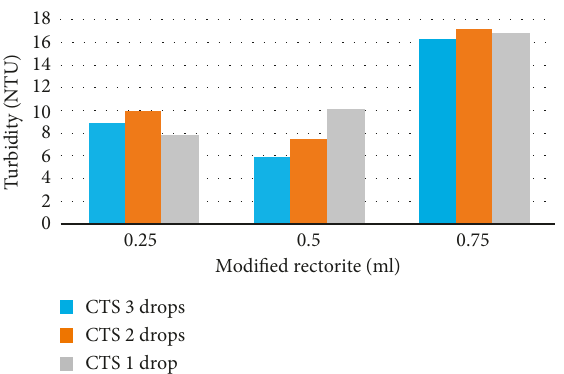
Figure 7: Turbidity of water treated with polyaluminum chloride and modified rectorite.